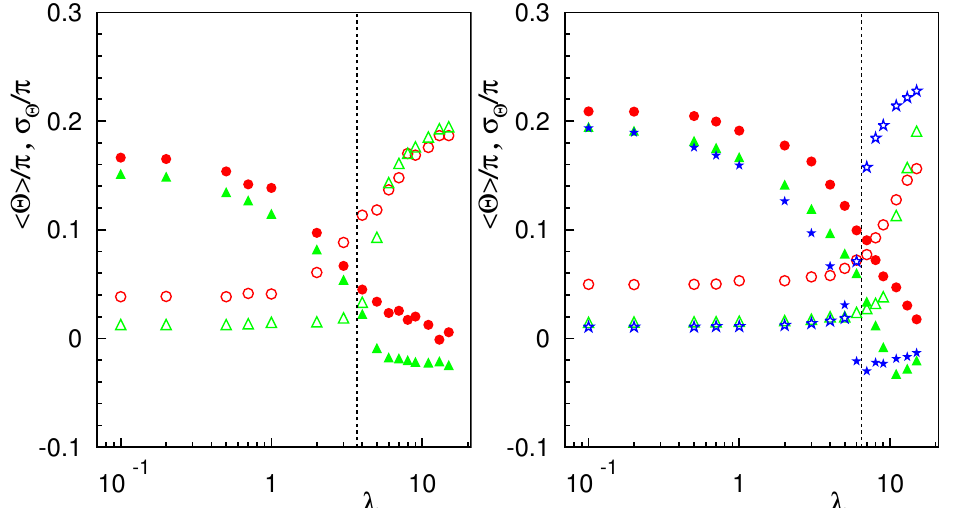
Figure 4. Average values of the inclination angle (cid:104) Θ (cid:105) (filled symbols) and its rms fluctuation values σ Θ (empty symbols) as a function of λ at S ∗ = 0.80 ( left ) and S ∗ = 0.95 (right ) for κ / ( k B TR 0 ) = 6.58 ( • ), 65.8 ( (cid:78) ), 164.5 ( (cid:63) ). The tank-treading to tumbling transition in the Keller–Skalak theory [5] is marked by the dashed vertical lines.